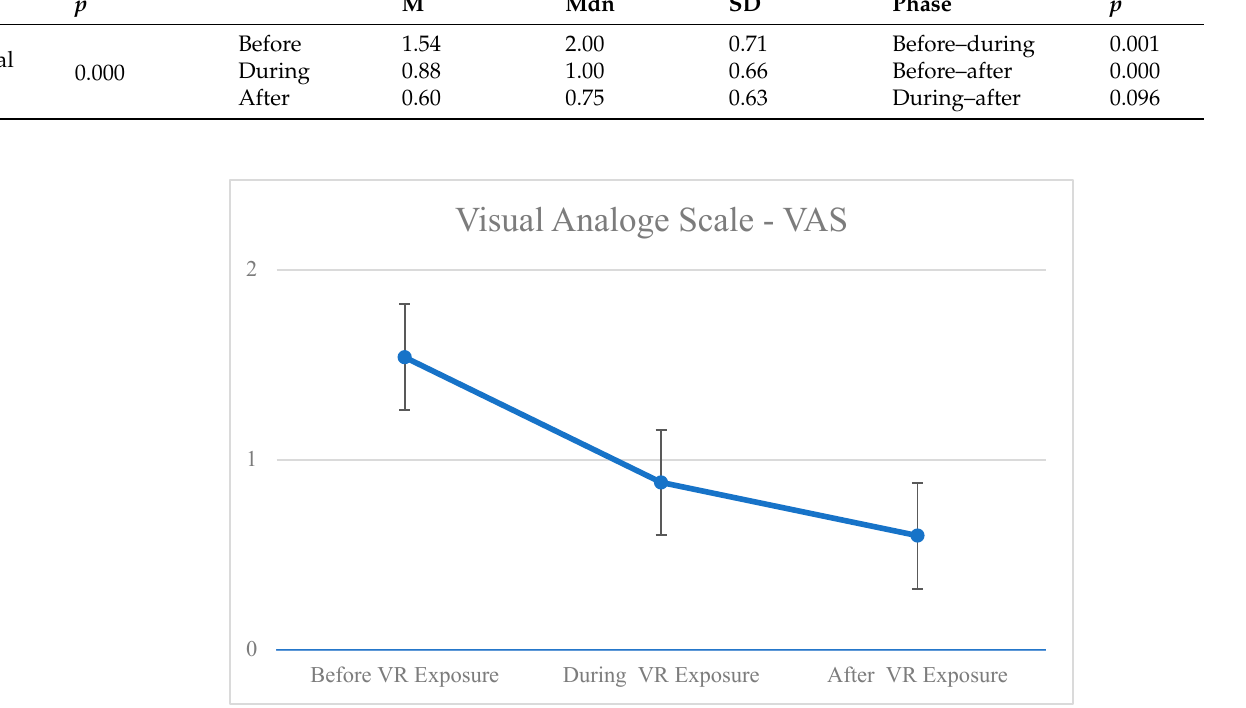
Figure 5. Emotions before, during, and after VR exposure using VAS.